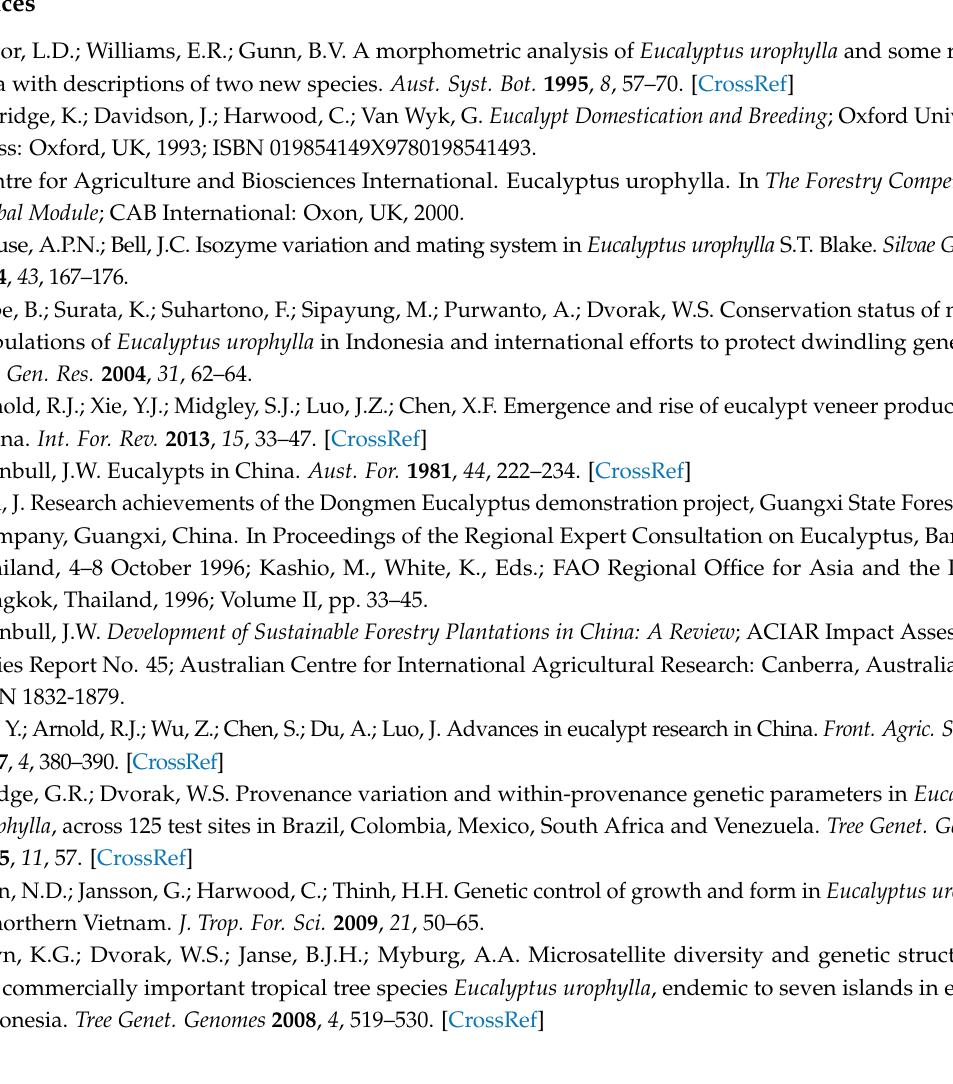
Table S1: Details of the E. urophylla trials comprising the first, second and third cycle breeding populations for this species in China. Table S2: Additional details on Trial T164 (third cycle breeding population). Figure S1: Locations of the E. urophylla trials comprising the first, second and third cycle breeding populations for this species in China. Author Contributions: W.L. and J.L. conceived and designed the study; W.L. and L.Z. organized and conducted the trial sampling and managed the samples; W.L. carried out the laboratory analyses; W.L., L.Z., J.L. and